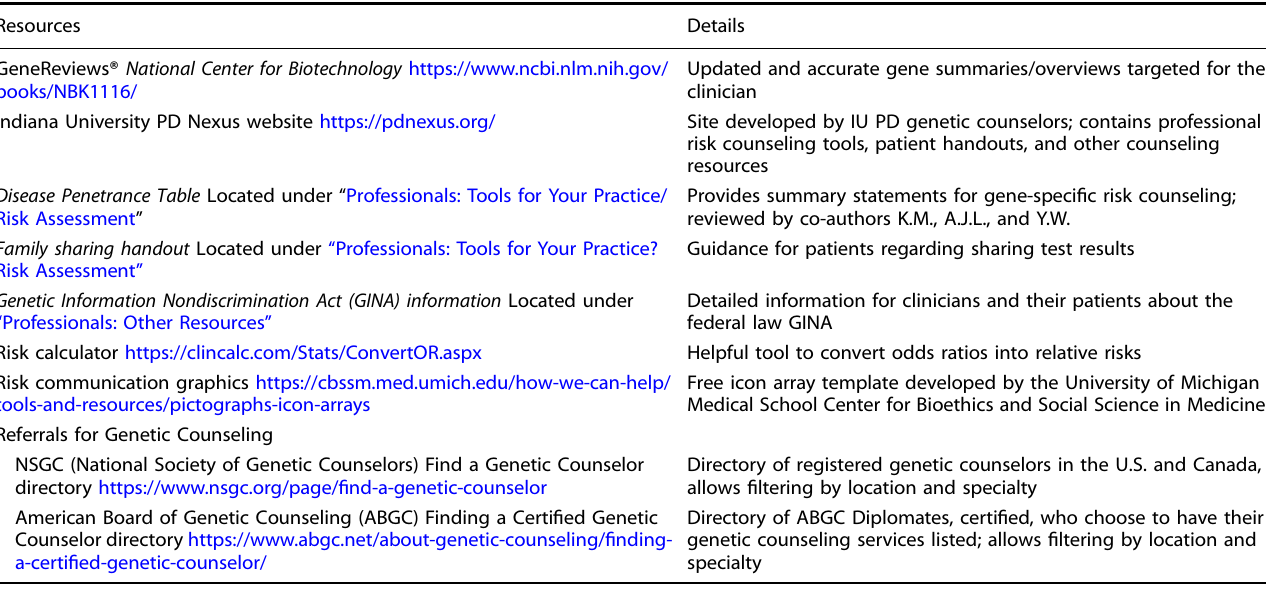
Table 5. Parkinson ’ s disease (PD) genetic risk communication resources for the